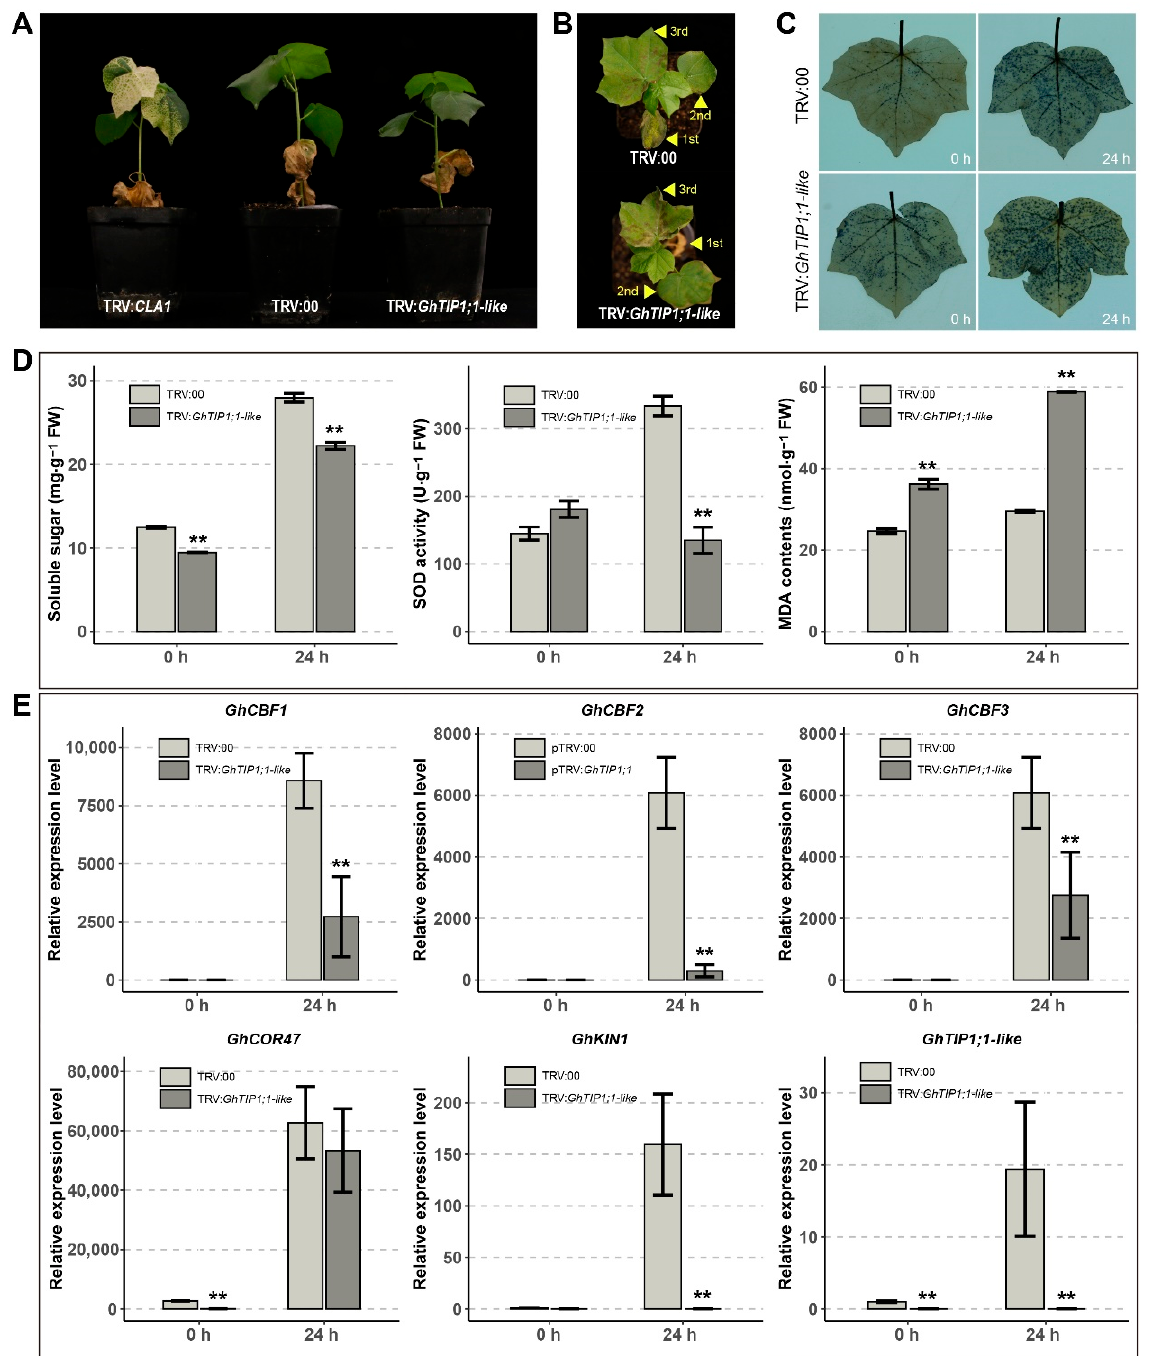
Figure 5. VIGS of GhTIP1;1-like gene in cotton. ( A ) The phenotype of cotton plants infiltrated with TRV: CLA1 , TRV:00 and TRV: GhTIP1;1-like . ( B ) Cold stress recovery assay of the GhTIP1;1-like -silenced (TRV: GhTIP1;1-like ) and control (TRV:00) plants after 3-days at 4 °C. Yellow triangles point to different true leaves. ( C ) NBT staining assay of the GhTIP1;1-like silenced and control plants in untreated (25 °C) and cold stress (4 °C) conditions. ( D ) Physiological indexes determination of GhTIP1;1-like -silenced and control plants in untreated and cold stress conditions. ( E ) Relative expression of cold-responsive genes in GhTIP1;1-like -silenced and control plants under cold stress conditions. Each experiment was repeated three times, with the bar representing the standard error (SE). Asterisks indicate a significant difference from the TRV:00 plants under the same cold condition at p < 0.01 as determined by a t